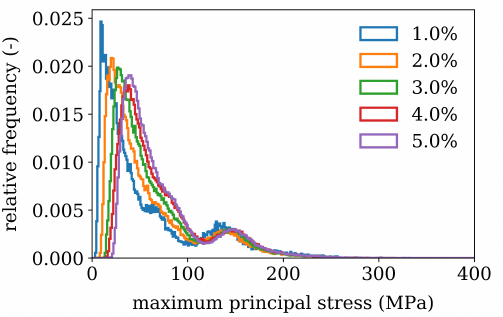
Figure 9. Histogram showing the relative frequency of maximum principle thermo-elastic stress after cooling for different precipitate volume contents ζ .